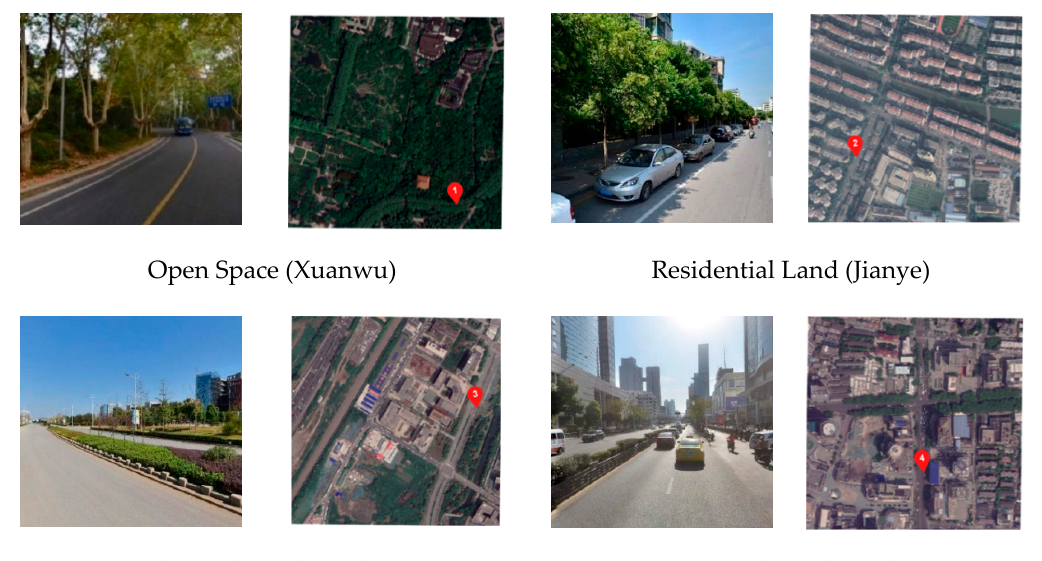
Figure 11. Comparison of street greenery from the eye-level and overhead perspective in different urban functional zones (UFZs). The eye-level image came from the street view image, and the overhead view came from Google Maps. The red marker in each satellite image indicates the location of the street view image.